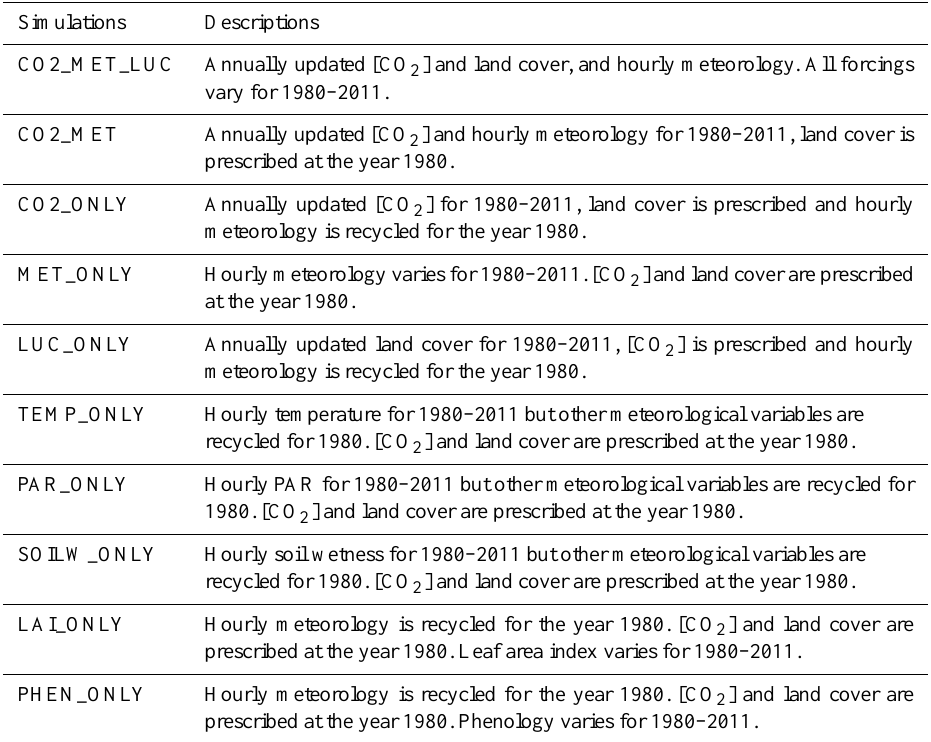
Table 1. Summary of model simulations driven with WFDEI